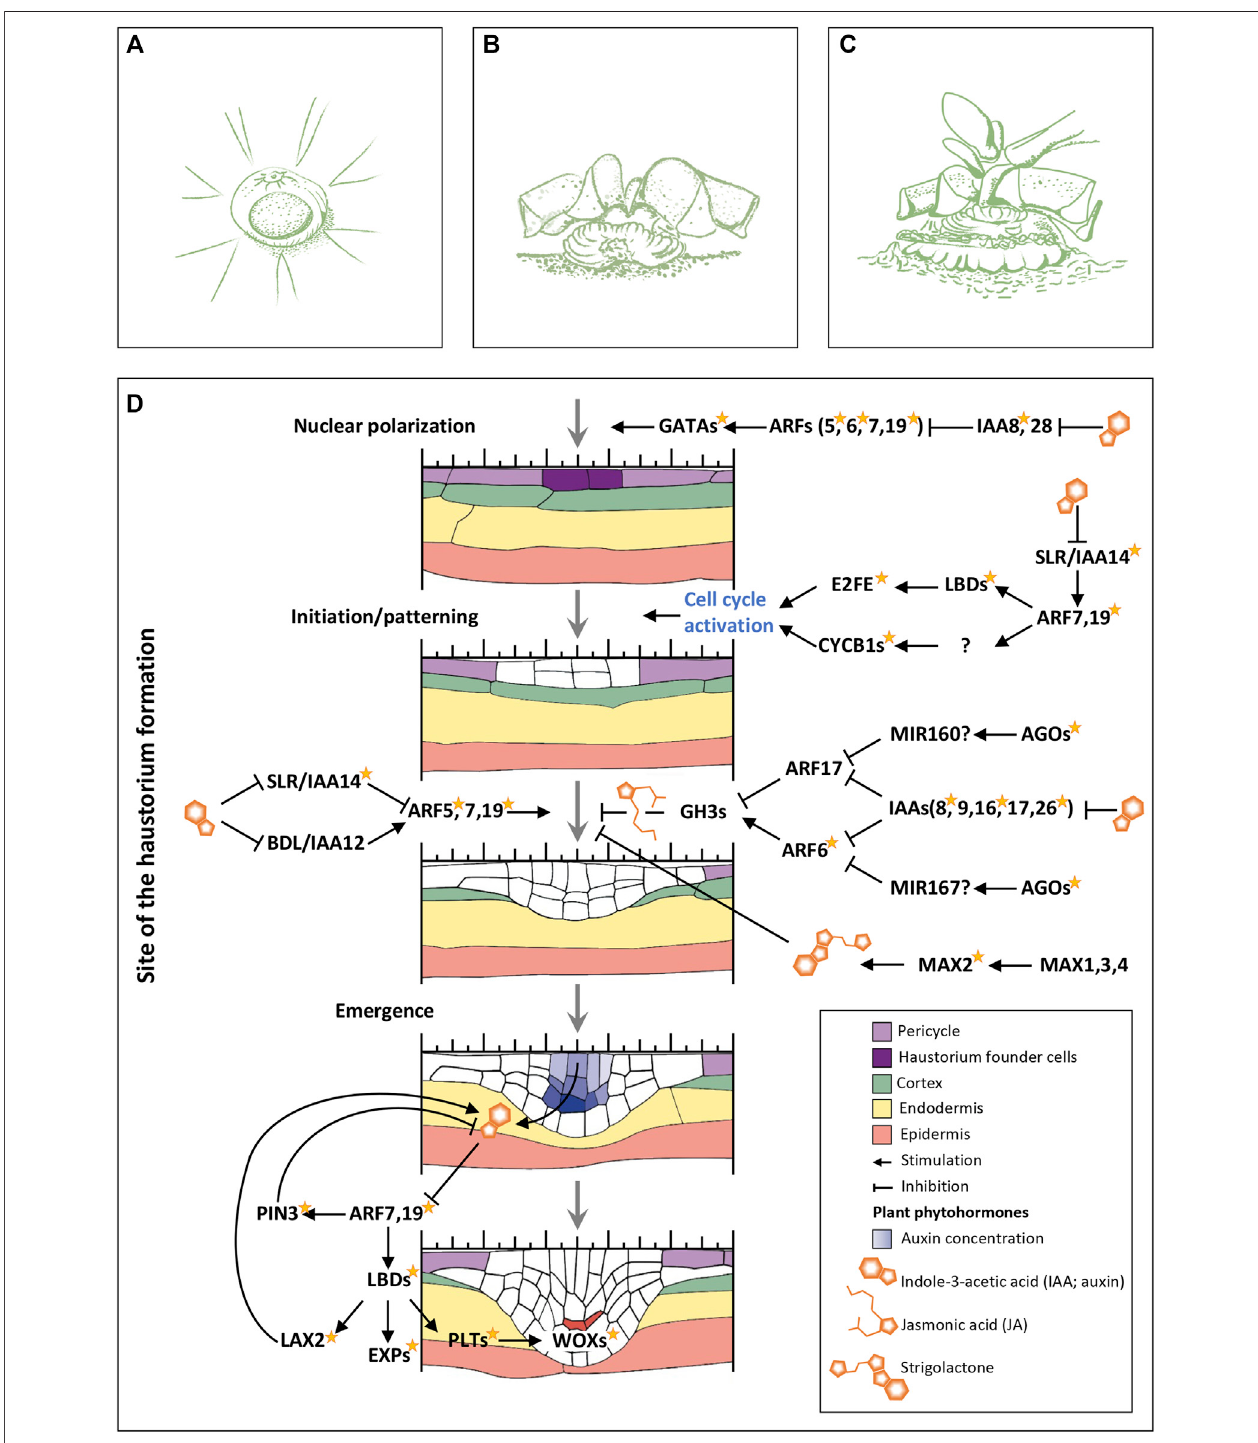
FIGURE 6 | Germination in Psittacanthus schiedeanus and genes network presumably involved in haustorium formation. (A) Seedling inverted which show the emergence of the (oval) primary haustorium just below the small suspensor scar. (B) Older seedling showing the grooved haustorial cushion formed upon penetration. (C) Establishedseedlingwithearlyprimaryleaves.Thetipsofprismaticlobesofstar-shapedbodiesareremovedin (B , C) (Re-drawnfromKuijt,1970,2009;Drawingsby Julieta Ornelas Peresbarbosa). (D) Gene ’ s network regulating intrusive organ formation (haustorium) in P. schiedeanus . Different colors denote different tissues. Initiation and emergence rely on gene networks regulated by auxin (IAA), jasmonic acid (JA), and strigolactones. The yellow star next to the name of some proteins indicatesthattheywereidenti fi edasDEGs.Genes/proteinswithaquestionmarkreferthosethatwerenotidenti fi